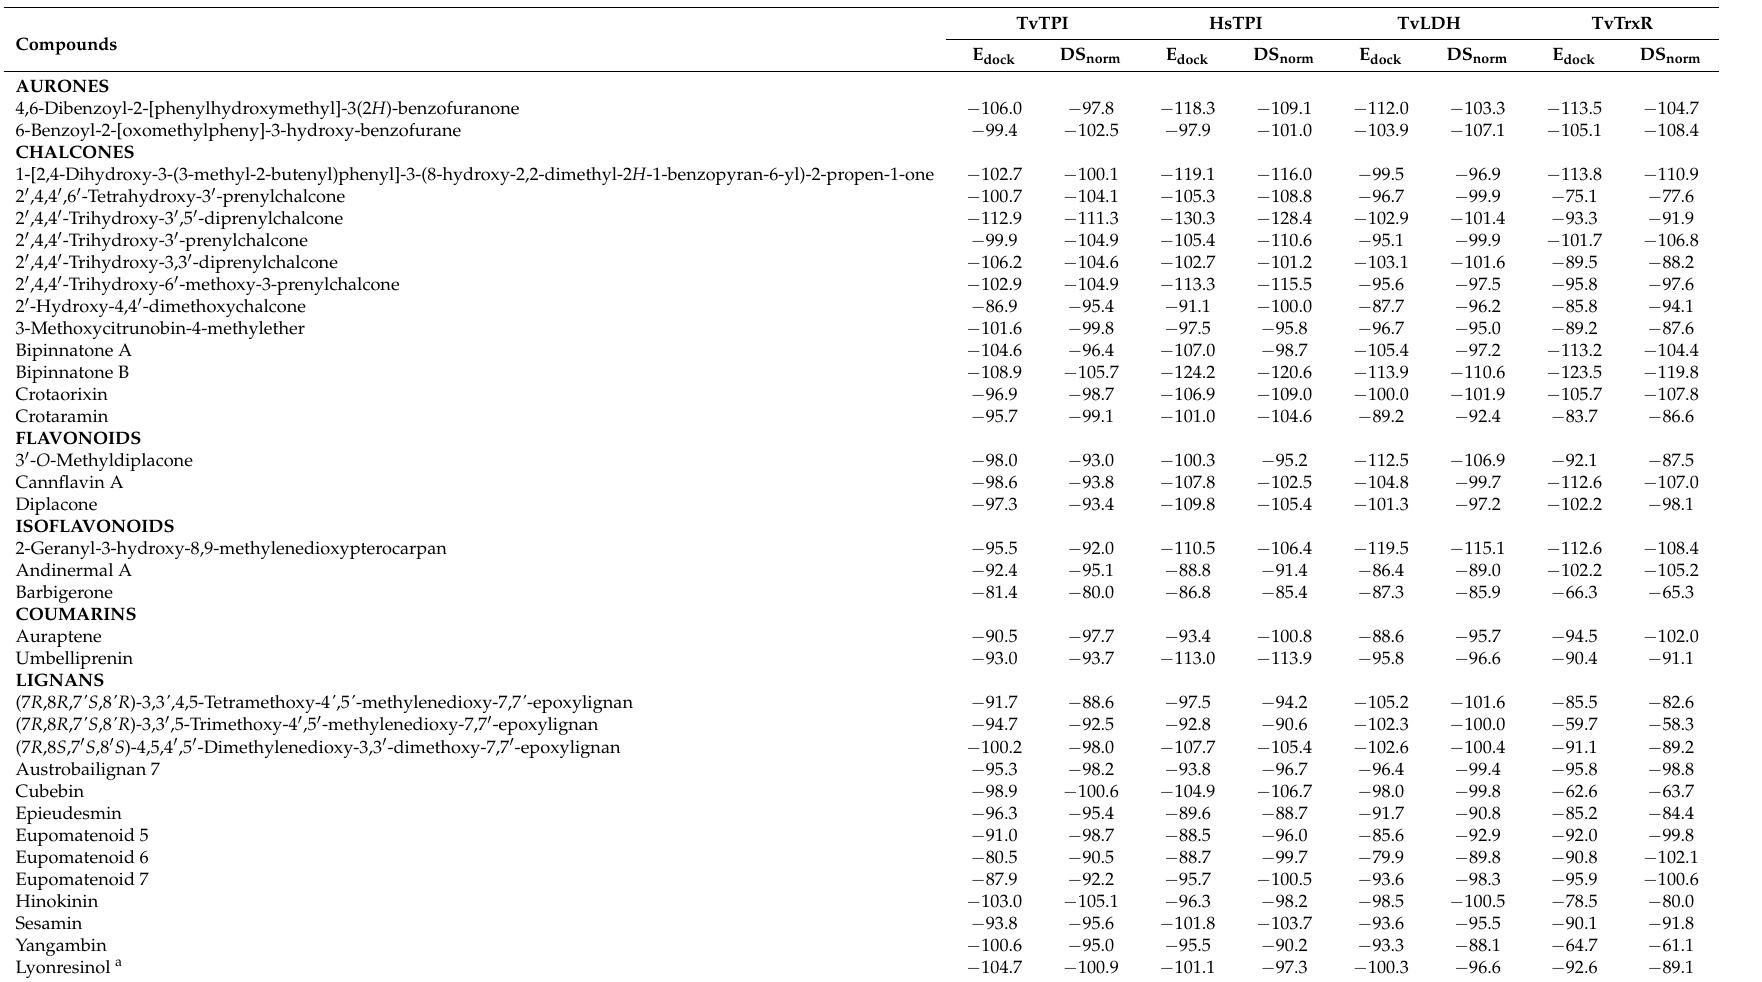
Table 4. MolDock (re-rank) docking scores and normalized docking scores (kJ/mol) for Trichomonas vaginalis and human triosephosphate isomerase (TPI), T. vaginalis lactate dehydrogenase (LDH) and T. vaginalis thioredoxin reductase (TrxR).